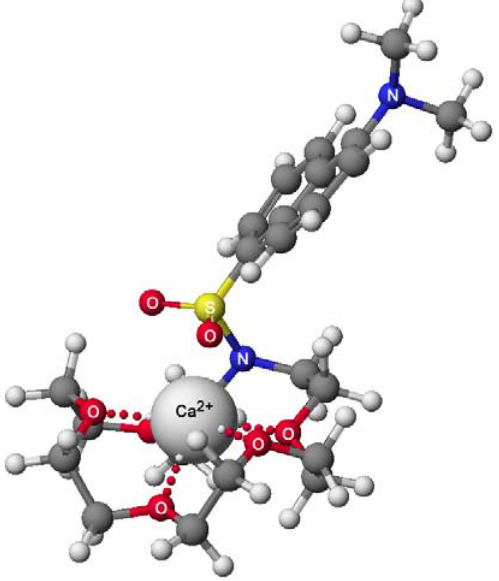
Fig. 8 The optimalized structure of (A18C6-Dns + Ca) 2+